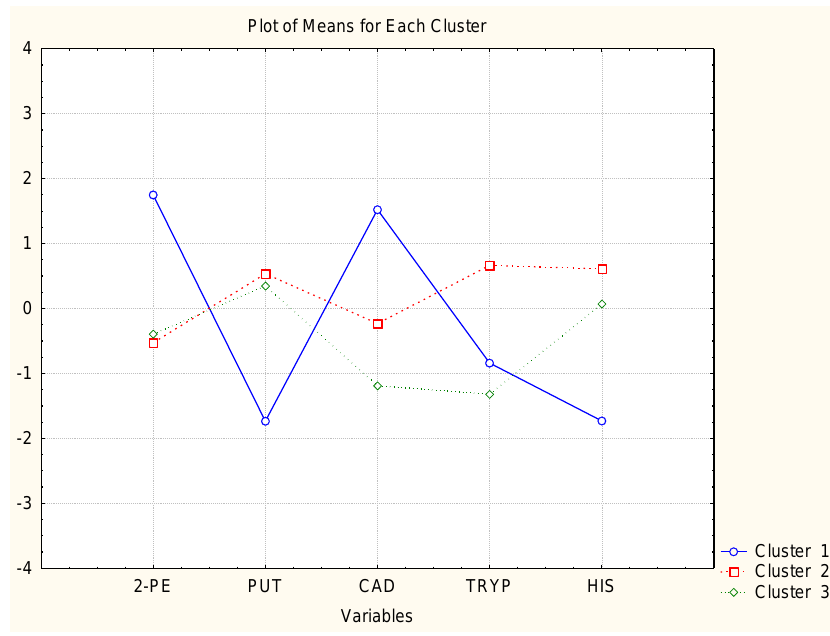
Figure 6. Averages of variables for each cluster (Wines D–F).